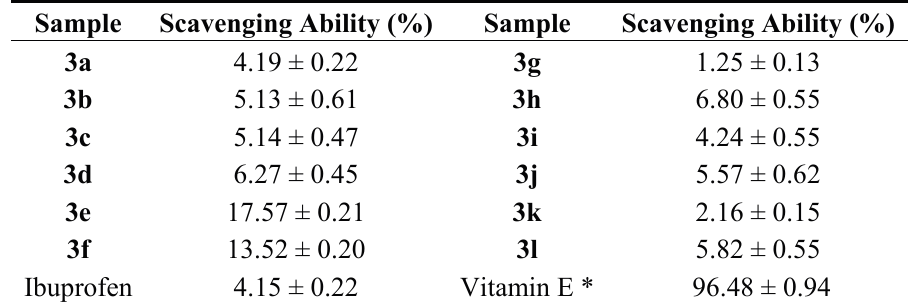
Table 4. The DPPH radical scavenging ability of the acyl hydrazone derivatives 3a – l .